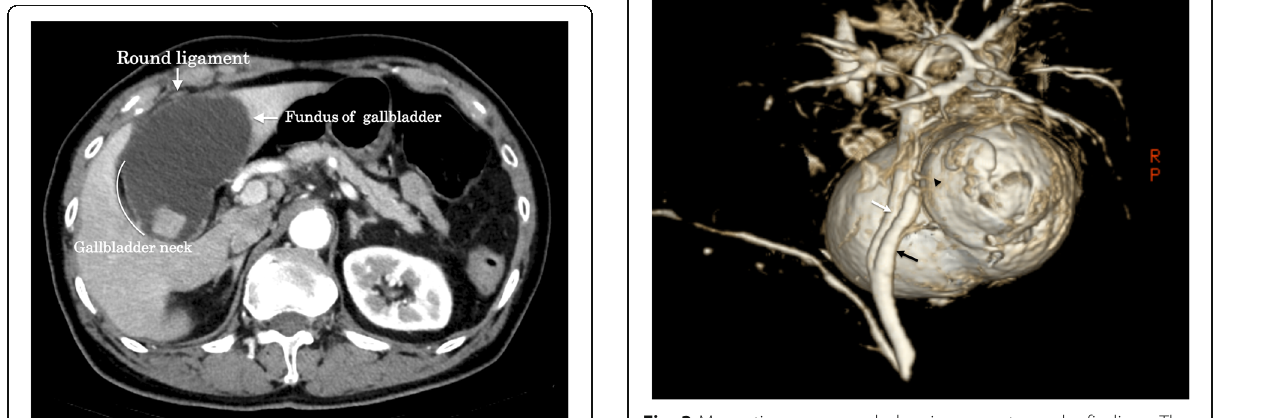
Fig. 3 Magnetic resonance cholangiopancreatography findings. The cystic duct (black arrow) branched from the common bile duct (white arrow). The cystic duct was unclear in the middle (black